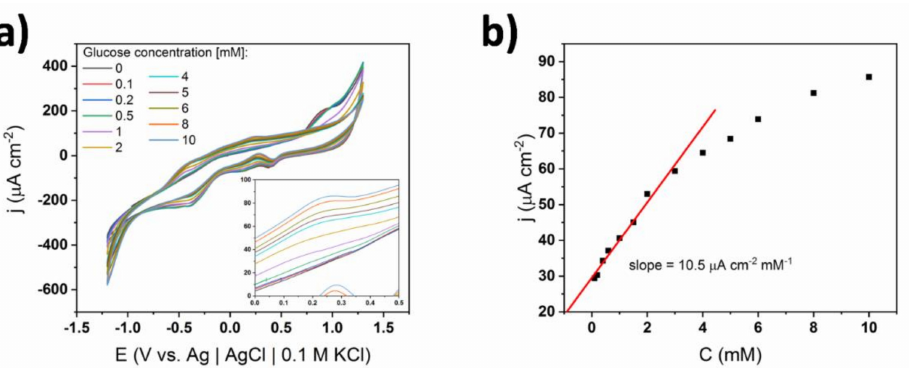
Figure 10. ( a ) Cyclic voltammograms of TiND | AuNP Nafion-coated electrode registered for di ff erent glucose concentrations in 0.01 M sPBS; inset—magnification of glucose oxidation peaks, ( b ) calibration curve based on glucose oxidation peak at + 0.35